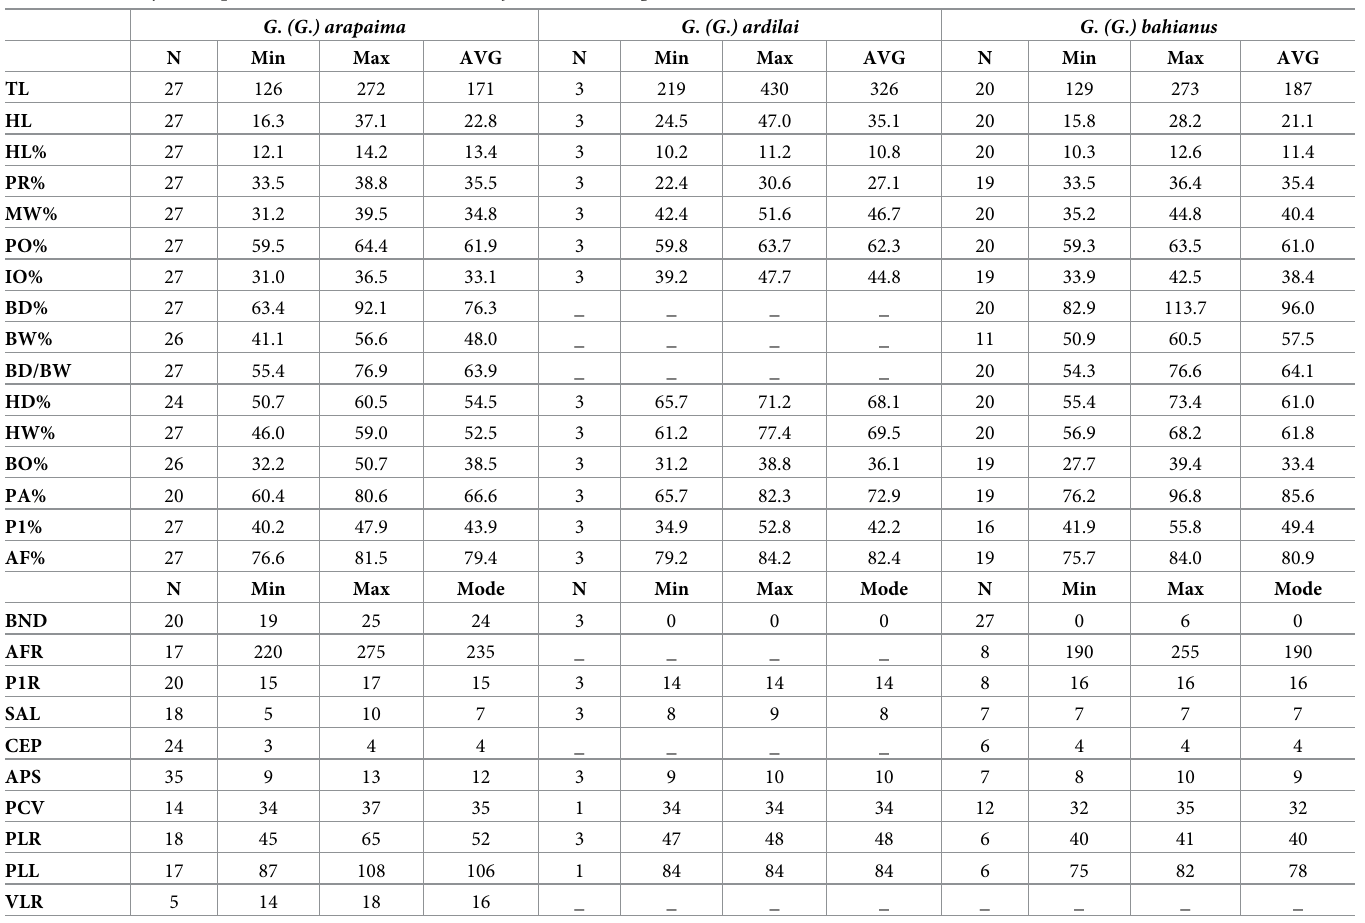
Table 6. Summary of morphometric and meristic data for Gymnotus (G . ) arapaima , G . (G . ) ardilai and G . (G . ) bahianus . G . (G . )